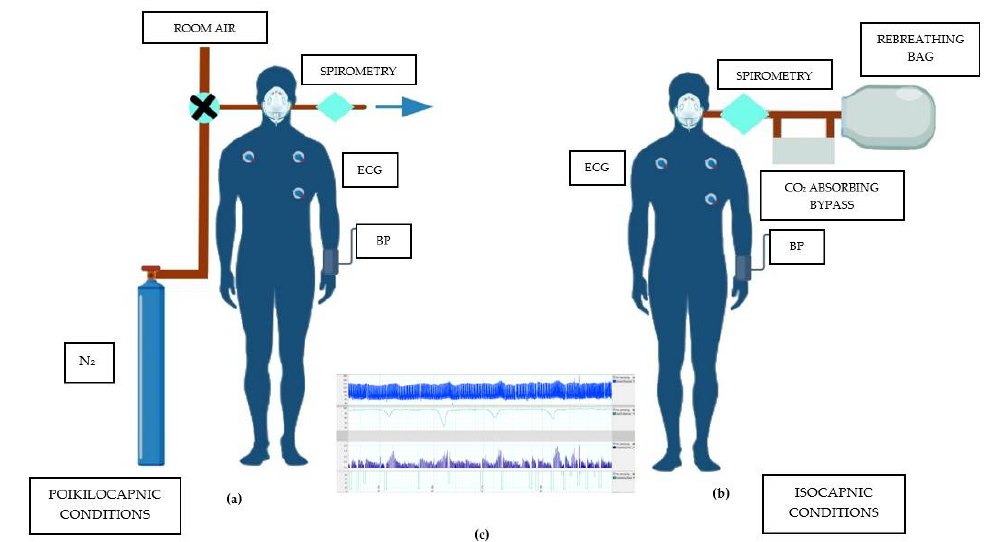
Figure 2. ( a ) Illustration of the transient hypoxia method; ( b ) Illustration of the isocapnic progressive hypoxic method (rebreathing technique); and ( c ) Example of the measurement of peripheral chemosensitivity. For each nadir of saturation minute ventilation, heart rate and systolic blood pressure values are plotted. BP—blood pressure; CO 2 —carbon dioxide; ECG—electrocardiography; and N 2 —nitrogen.